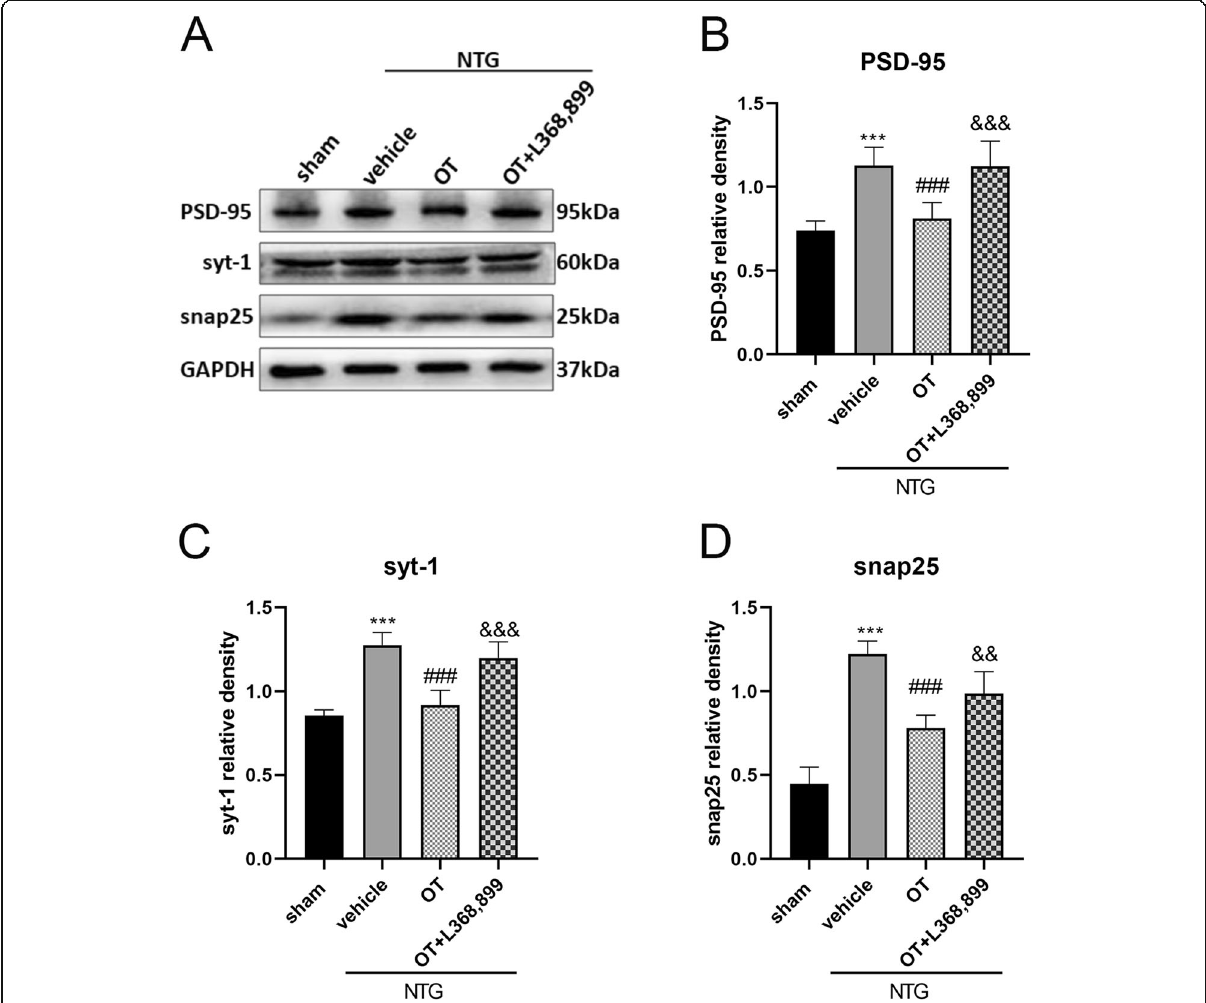
Fig. 6 Effect of OT on synapse-associated protein expression levels. A Representative WB bands showing the expression of PSD-95, syt-1, and snap25. B , C , and D Quantification of PSD-95 ( B ), syt-1 ( C ), and snap25 ( D ) protein levels showed that these proteins were significantly increased in the NTG + vehicle group compared to the sham group. The expression levels of these three proteins after OT treatment were reduced, while L368,899 blocked these effects. One-way ANOVA with Dunnett ’ s post hoc test, n = 6/group; *** p < 0.001 vs. the sham group; ### p < 0.001 vs. the NTG + vehicle group; && p < 0.01, &&& p < 0.001 vs. the NTG + OT